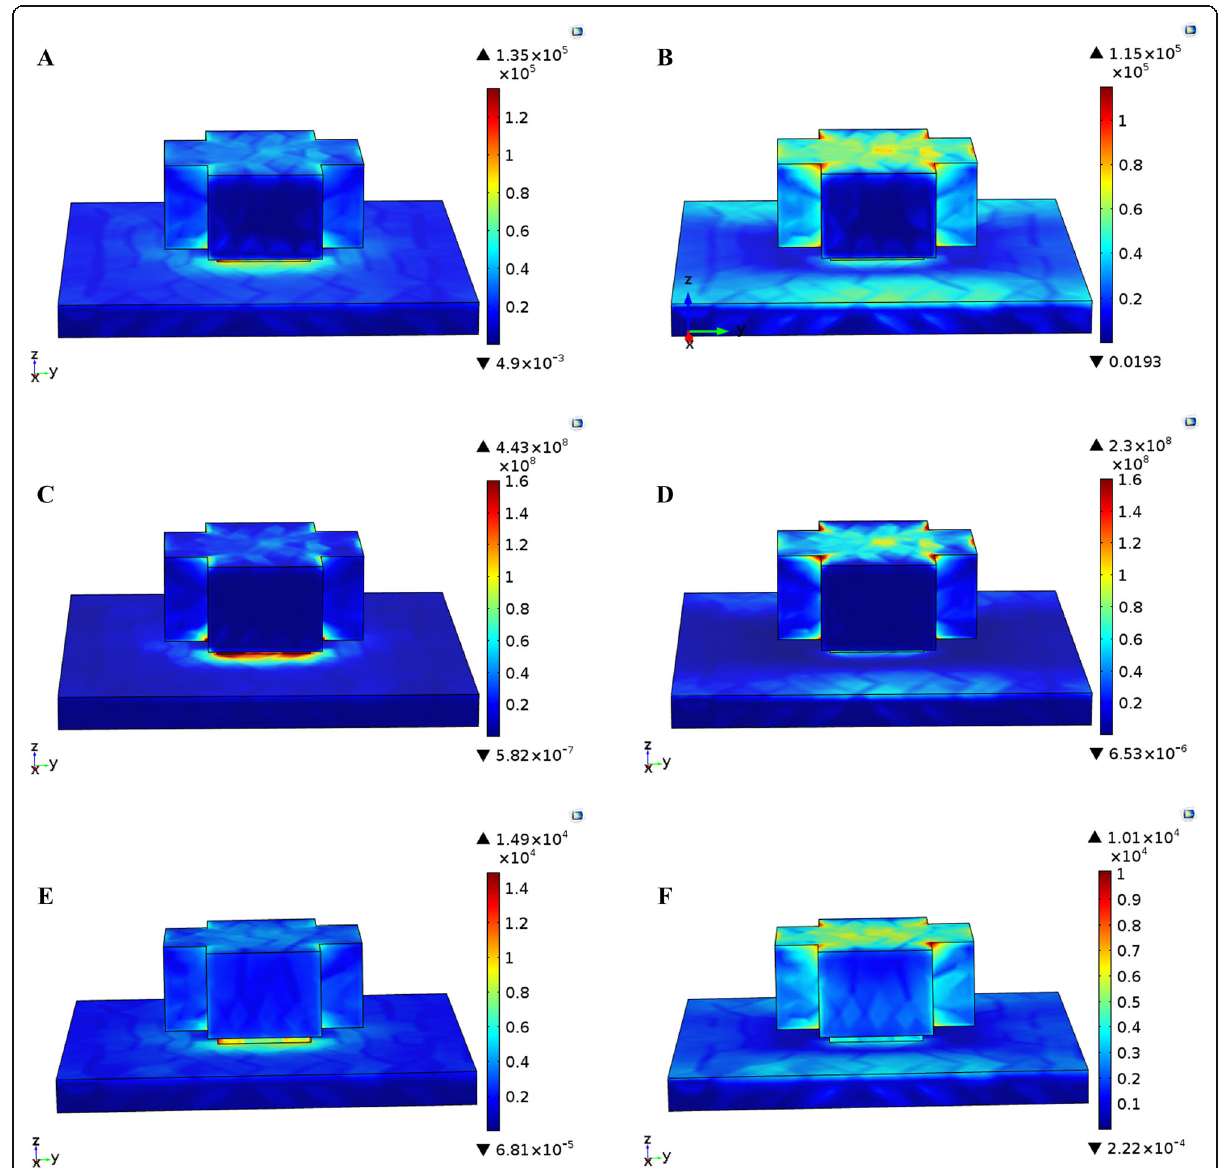
Fig. 14 Simulated current density [ a 9 GHz, b 15.4 GHz], power loss density distribution [ c 9 GHz, d 15.4 GHz], and electric field distribution [ e 9 GHz, f 15.4 GHz] the radar absorbing